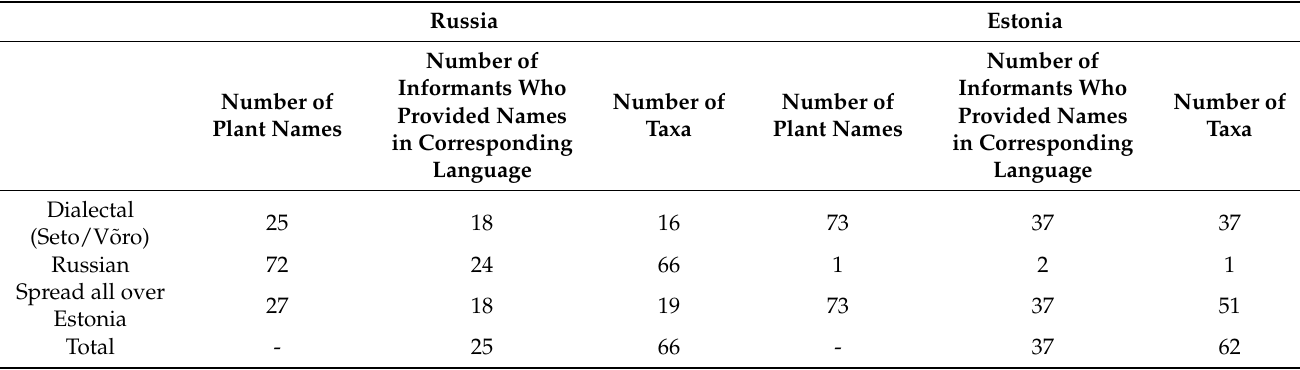
Table 6. Wild food plant names recorded from Setos in Russia and